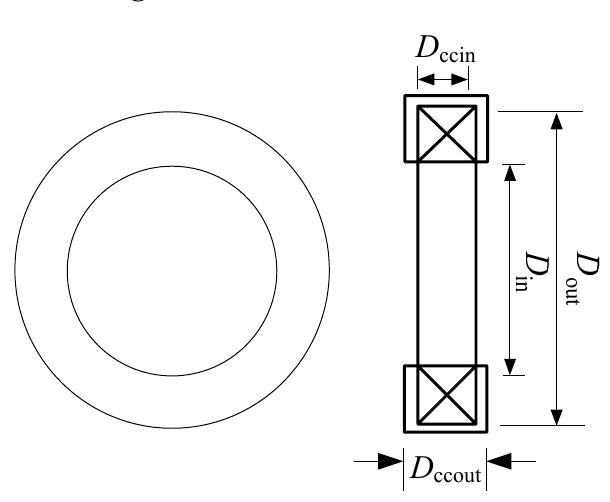
Figure 4. Structure of the air coil.